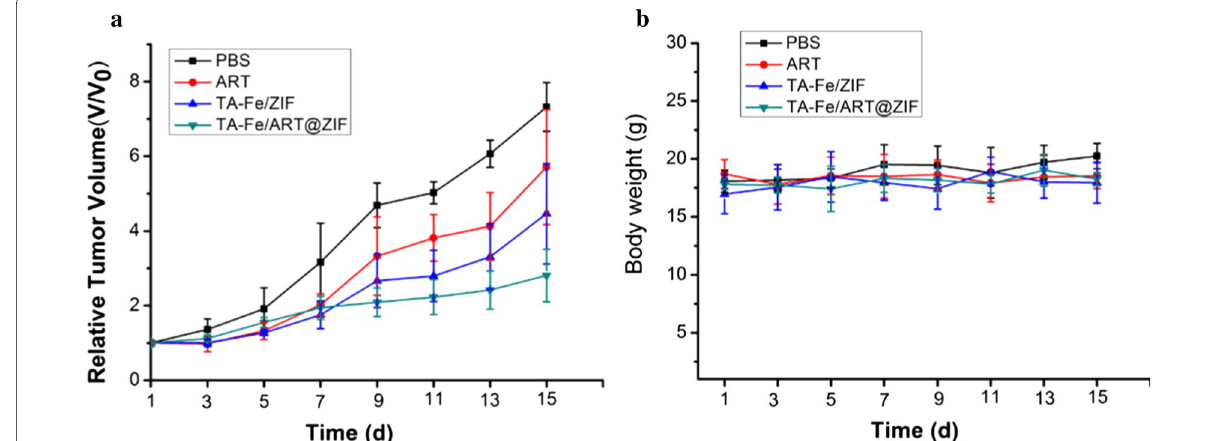
Fig. 7 a Relative tumor volume after treated with treated with PBS, ART, TA-Fe/ZIF, and TA-Fe/ART@ZIF nanoparticles. b Relative mice body weight of various groups